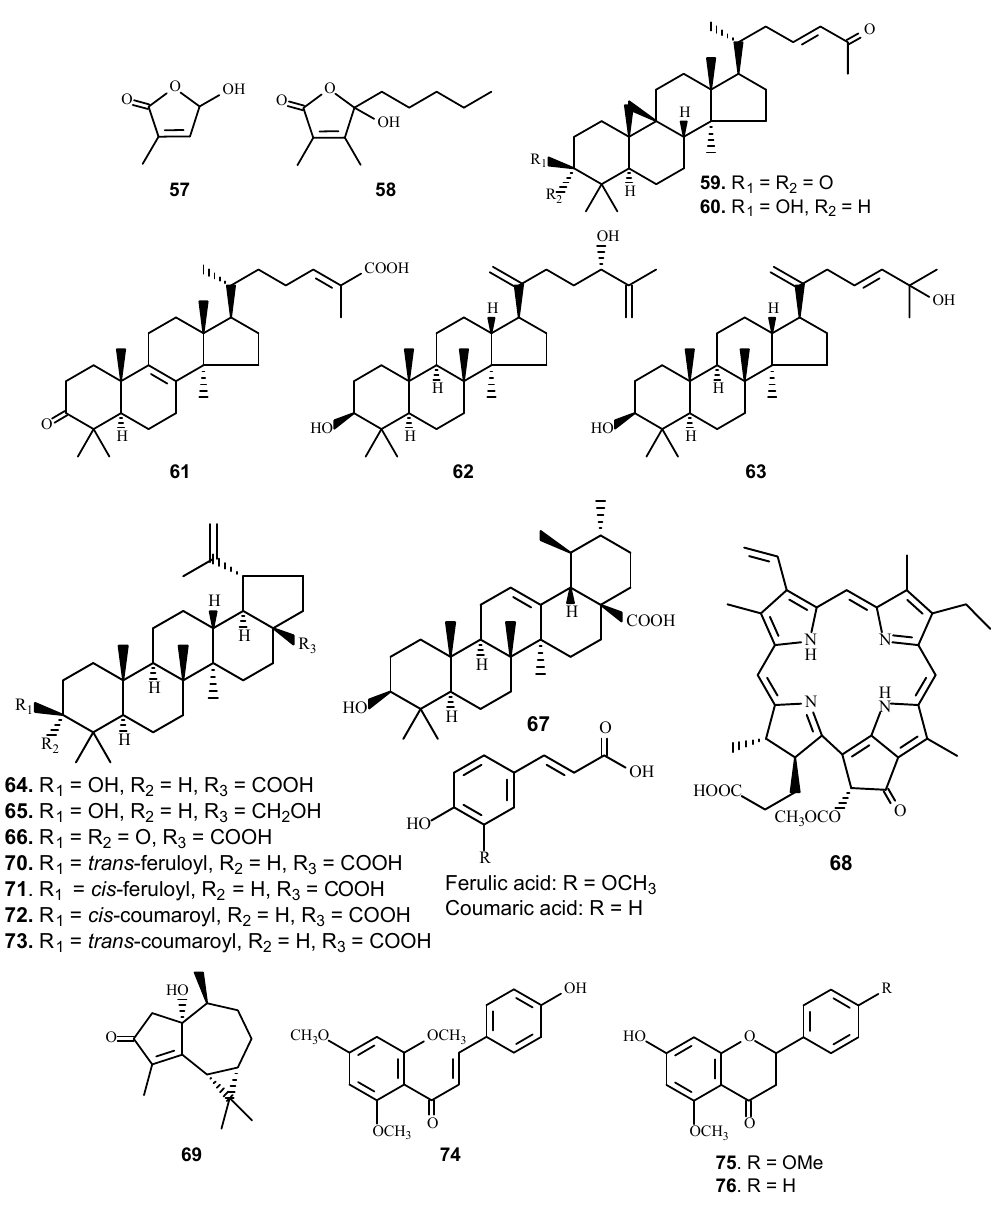
Figure 2. The chemical structures of compounds 35 – 76 .